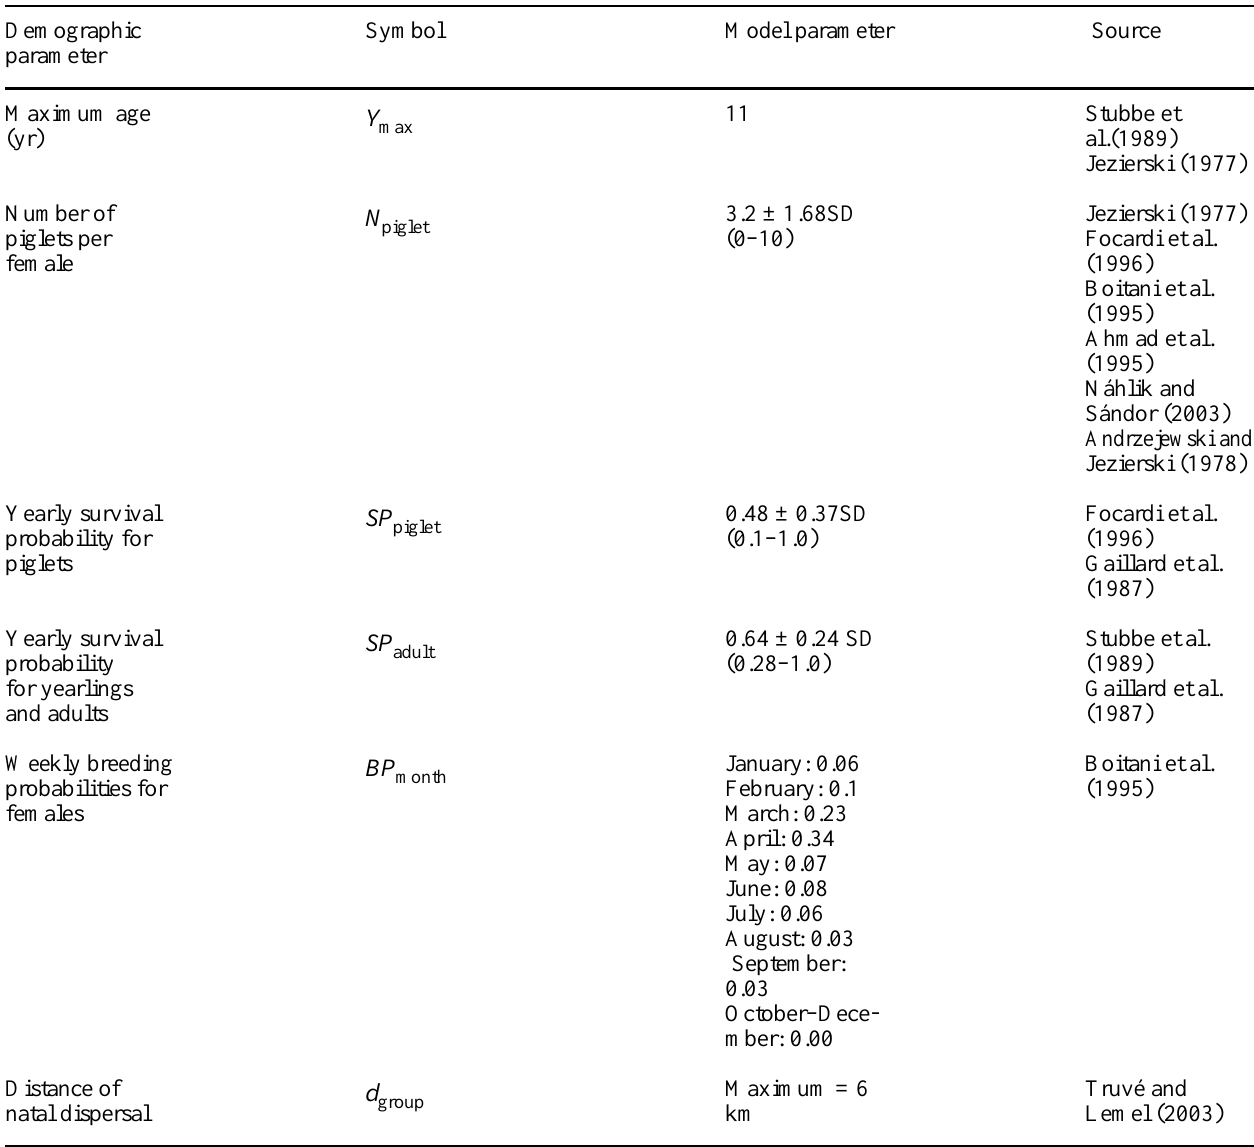
Table 1 . Wild boar demographic parameters used in the individual-based population model. Mean values are given with standard deviation (SD). Values between brackets indicate the parameter